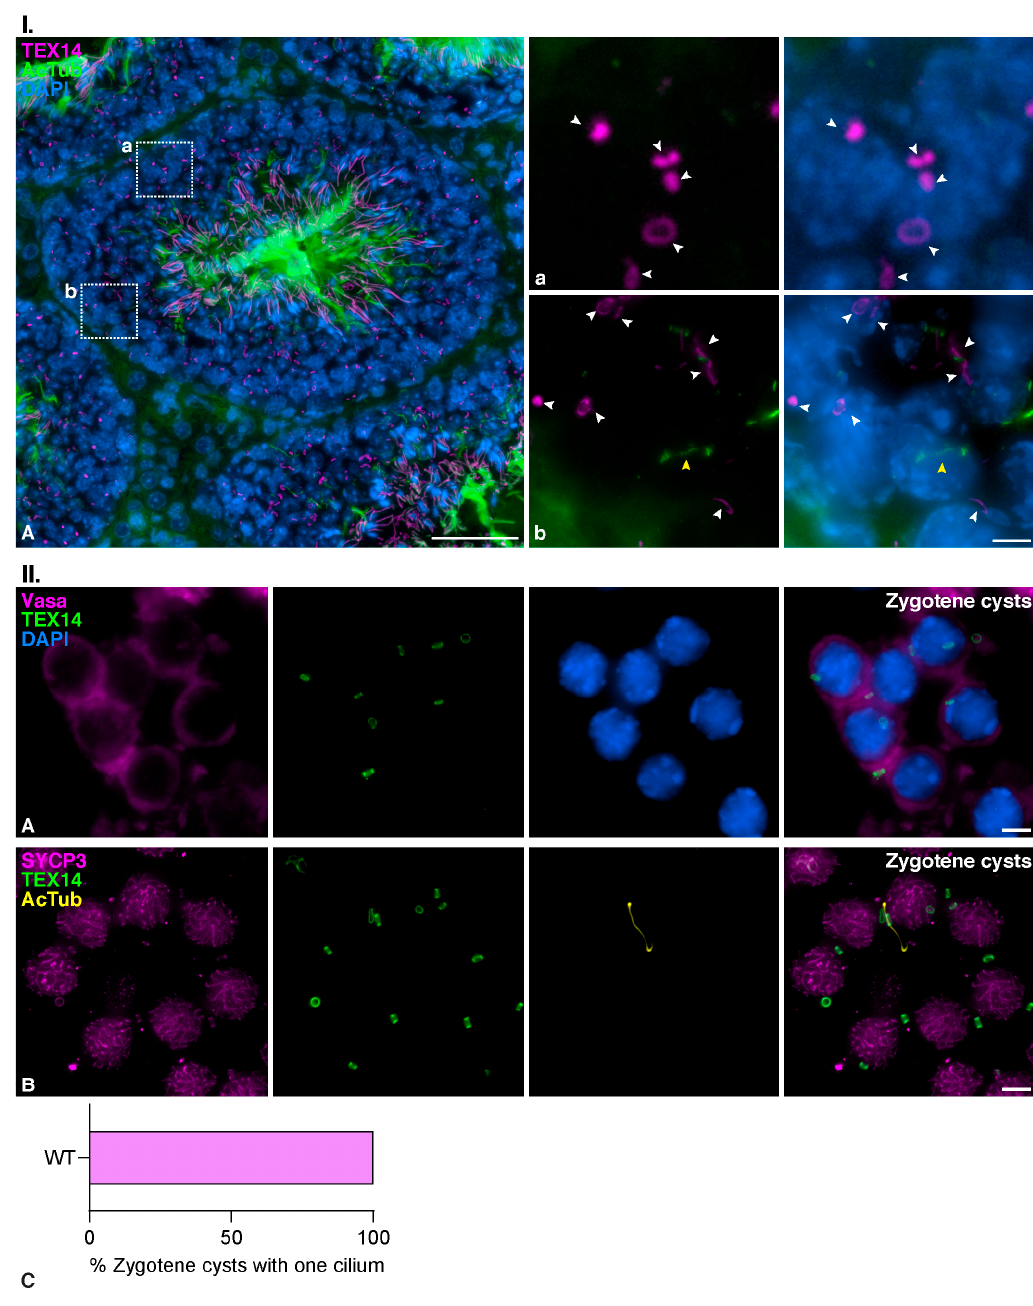
Figure 7. Spermatocyte cysts share cilia among several spermatocytes at zygotene. ( I ) . Distribu- tion of TEX14 cellular bridges in mouse testis cryosections; Double immunolabelling of TEX14 (magenta) and acetylated tubulin (AcTub) (green), with chromatin stained with DAPI (blue) on cryosections of mouse testis. ( A ) Complete section of a seminiferous tubule. Scale bar in A represents 50 µ m. ( a ) Magnified selected (dotted square) cyst of primary spermatocytes interconnected by TEXT14 bridges (white arrowheads), and ( b ) magnified selected (dotted square) cyst of primary spermatocytes interconnected by TEXT14 bridges (white arrowheads), with one zygotene showing a primary cilium (yellow arrow). White arrowheads in a and b indicate TEX14 bridges. Scale bar in b represents 5 µ m. ( II ) . Distribution of TEX14 cellular bridges in mouse spermatocytes at